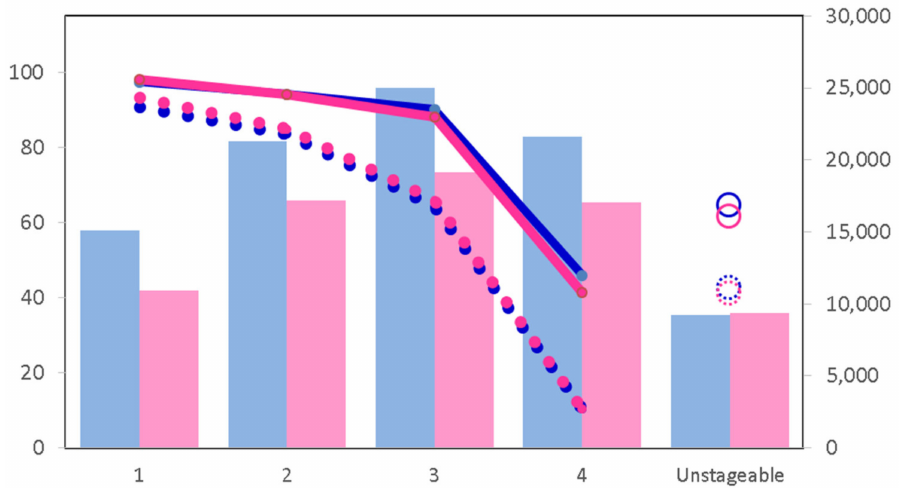
Figure 1. Bowel cancer survival by stage of disease at diagnosis. Solid blue and red lines denote one-year survival post-diagnosis for males and females, respectively. Open circles show survival rates (%) for males and females (blue and red, respectively) where no staging data are available. Dotted lines indicate five-year net survival. Numbers of cases are shown as blue bars (males) and pink bars (females)—right vertical axis. Horizontal axis—stage at diagnosis. Data are from [9] and refer to adults diagnosed in 2013–2017 and followed up to